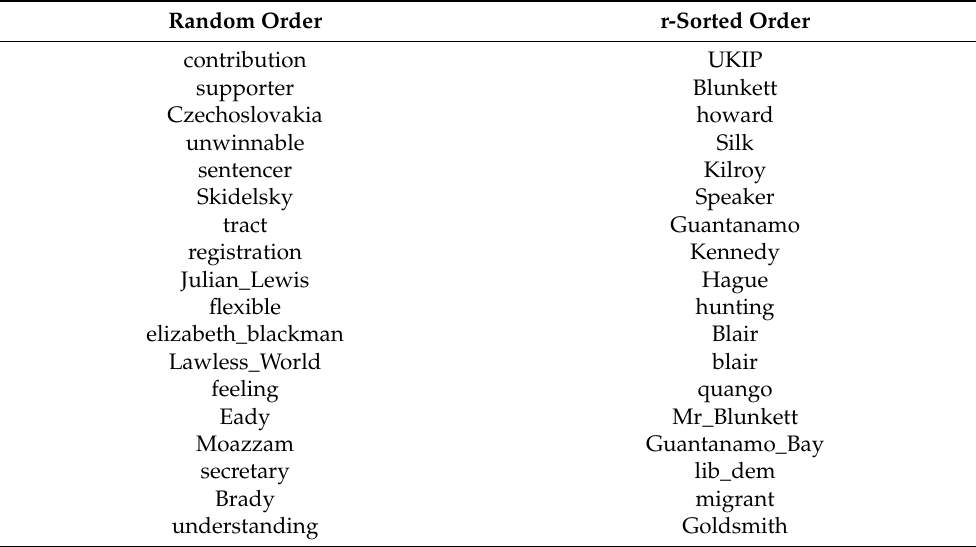
Table 1. Comparison of selected terms of the same topic. The left column picks some random terms; the right column shows the terms with highest r value. Random